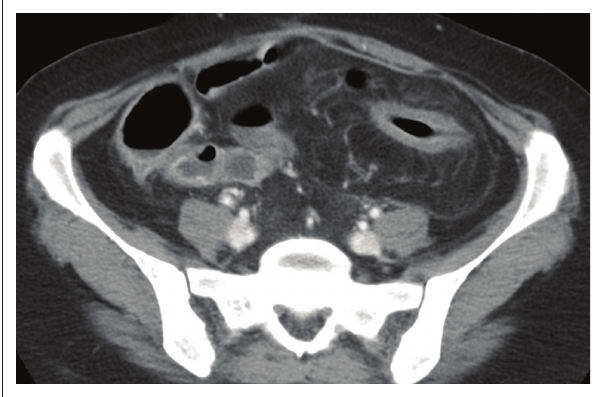
FIGURE 3: Axial images of the abdomen in venous phase after IV contrast